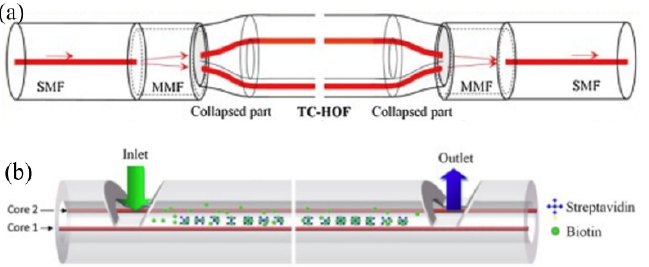
Figure 7. Schematic diagrams of the ( a ) structure and ( b ) microfluidic path of twin-core hollow optical fiber. Reprinted with permission from [104].